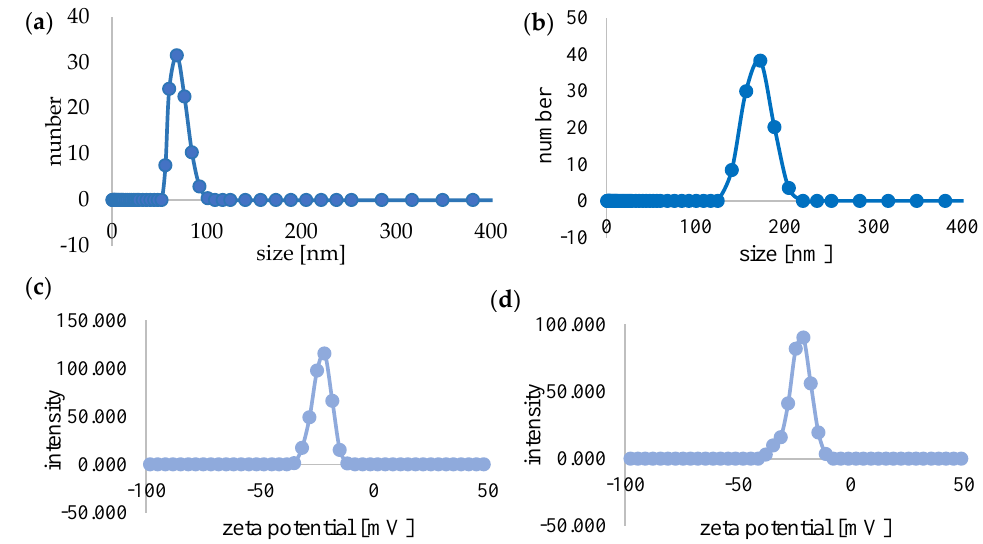
Figure 2. Biophysical characterisation of C 60 and complexes of C 60 -DOX. Particle size distribution diagram of the C 60 ( a ) and C 60 -DOX complexes ( b ). Zeta potential of C 60 ( c ) and C 60 -DOX complexes ( d ).